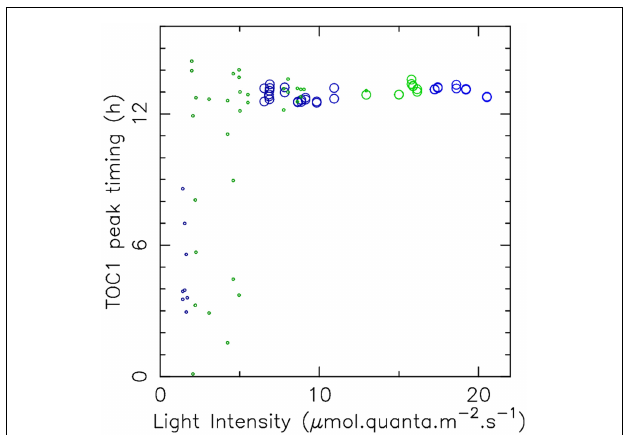
FIGURE 5 | Dependance of entrainment on light intensity. The timing of TOC1 expression peak under LD 12:12 cycles is displayed as a function of light intensity for green light (green circles) and blue light (blue circles). Large circles correspond to situations where large amplitude, reproducible, oscillations indicate stable entrainment. Small circles indicate cases where the luminescence signal was low, with no oscillations clearly discernible. Raw data are displayed in Supplementary Figure